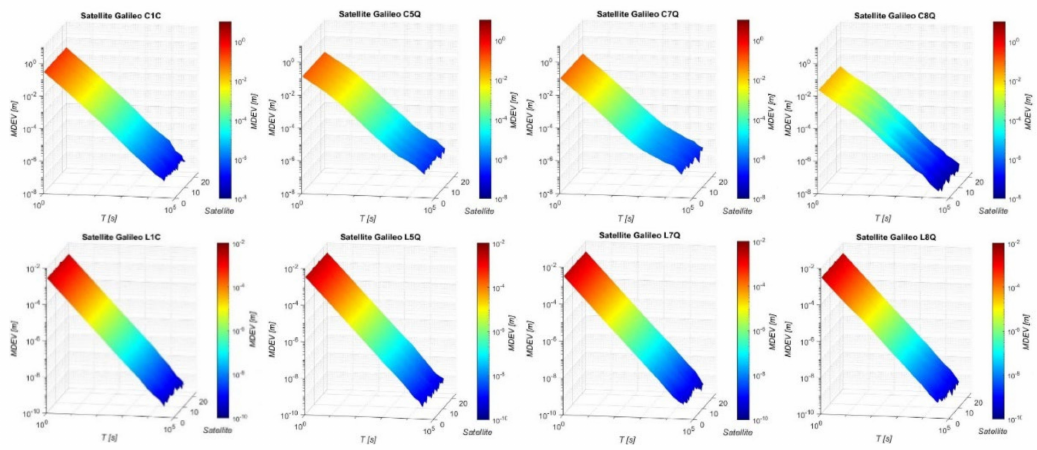
Figure 14. MDEV of the analyzed observation type for Galileo